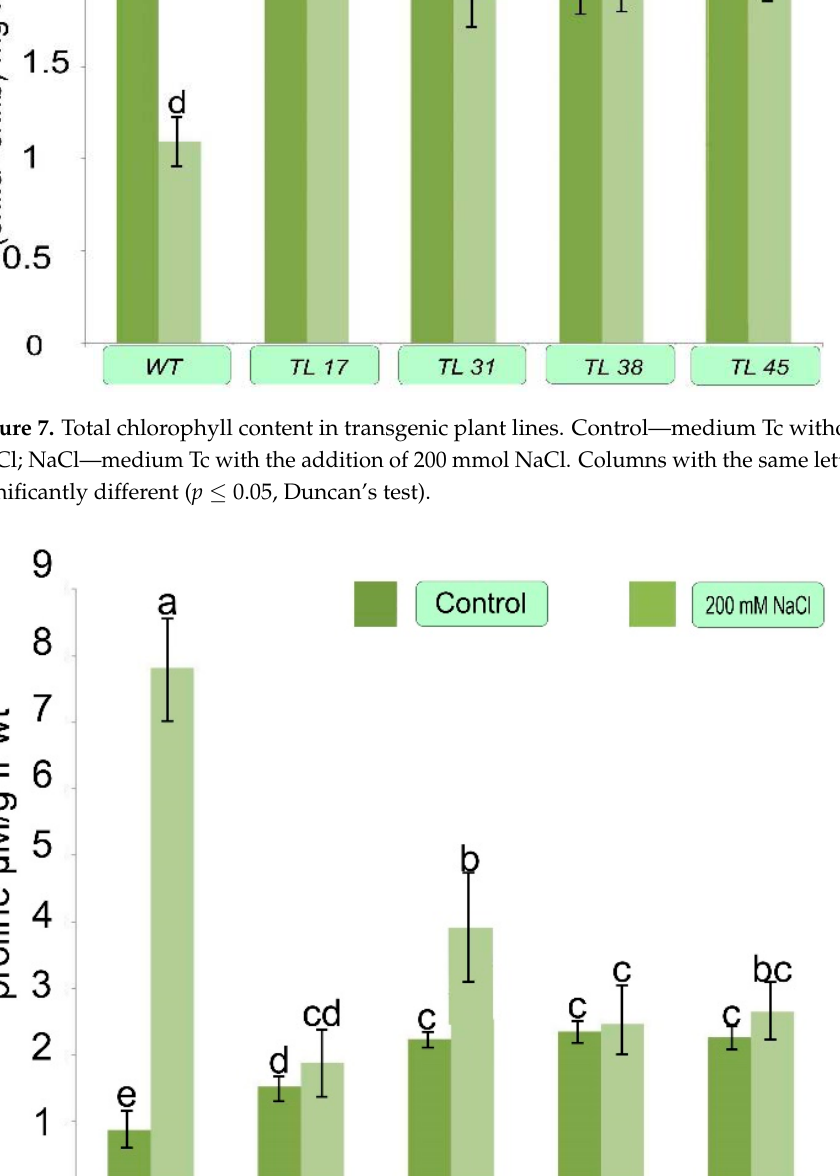
Figure 8. Proline content in transgenic plant lines. Control—medium Tc without adding NaCl; NaCl—medium Tc with the addition of 200 mmol NaCl. Columns with the same letters are not significantly different ( p ≤ 0.05, Duncan’s test).